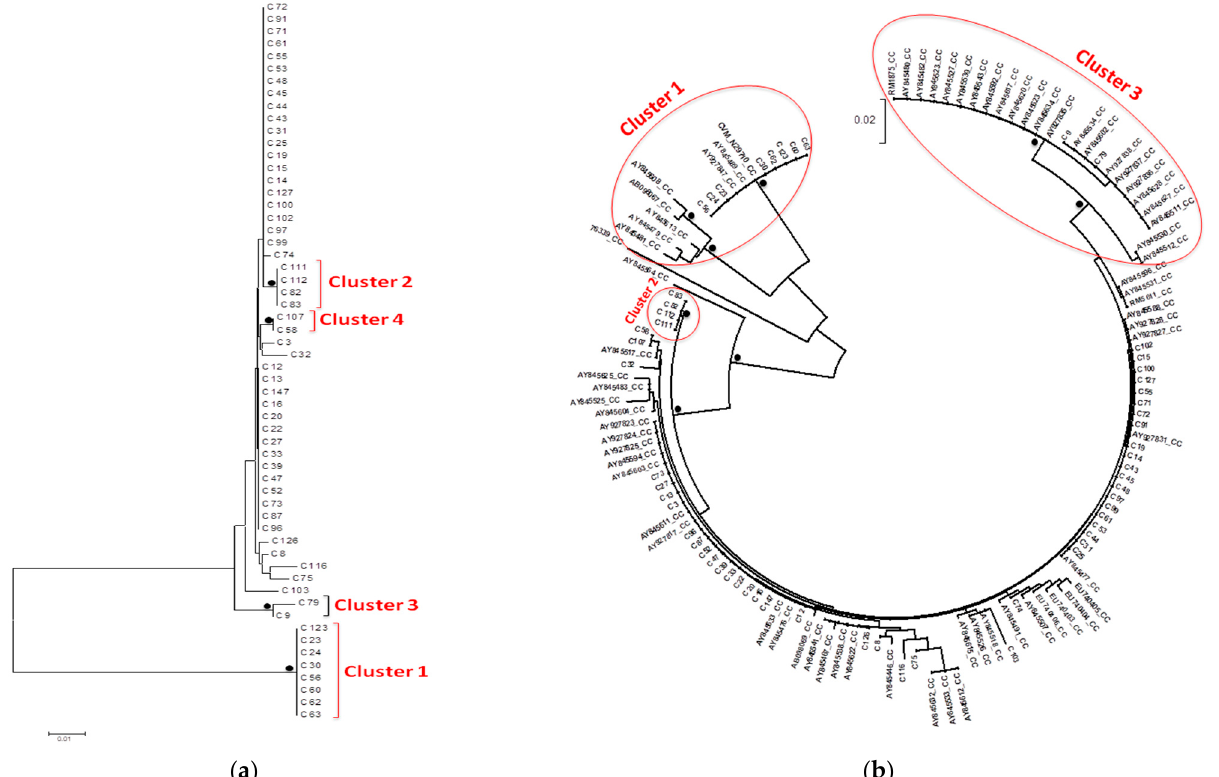
Figure 2. Campylobacter coli phylogenetic trees. Bullets represent clades, which had bootstrap values >75% of permuted trees. ( a ) The optimal tree with the sum of branch length = 0.21165541 is shown. The analysis involved 58 sequences. Most of the sequences were dispersed within the tree, whereas four significant sequence clusters were noticed. ( b ) The optimal tree with the sum of branch length = 0.54 is shown.